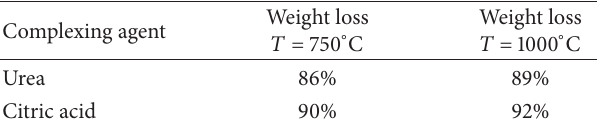
Table 1: Weight loss of powders versus annealing